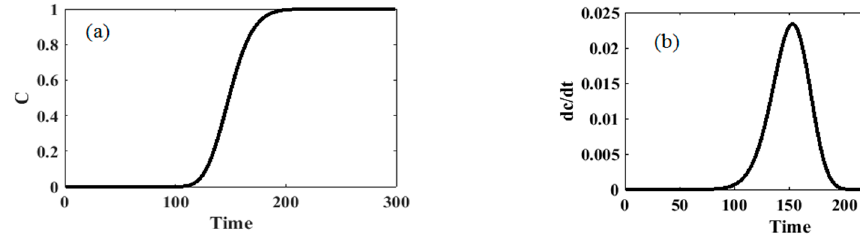
Figure 1. ( a ) Breakthrough curve; ( b ) derivative of the breakthrough curve (TF).